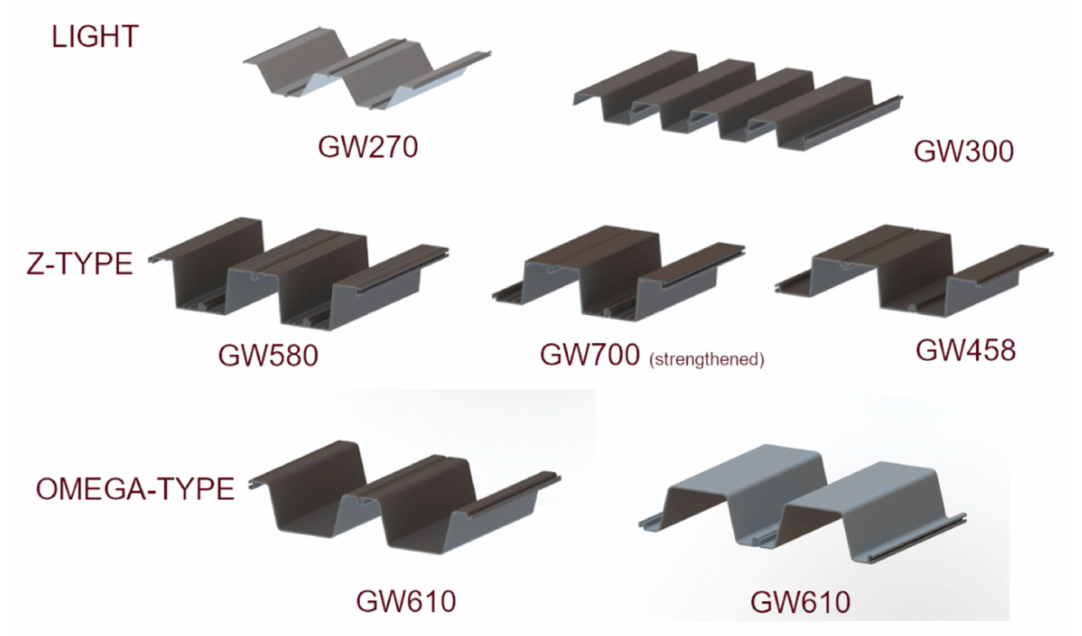
Figure 3. Panel profiles were studied in this work. Table 1. The parameters of studied fluted PVC panels. Panel Commercial Young’s Poisson’s Cross-Sectional Thickness mm Mark Modulus GPa Ratio Panel Height mm Panel h GW270